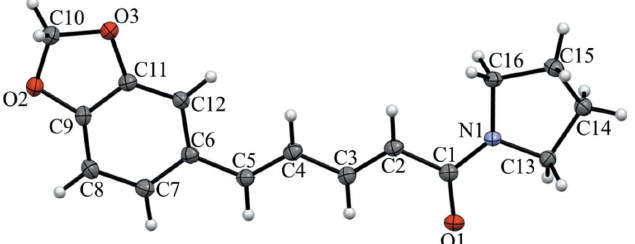
Figure 3 Displacement ellipsoid drawing at a 50% probability level of the asymmetric unit of